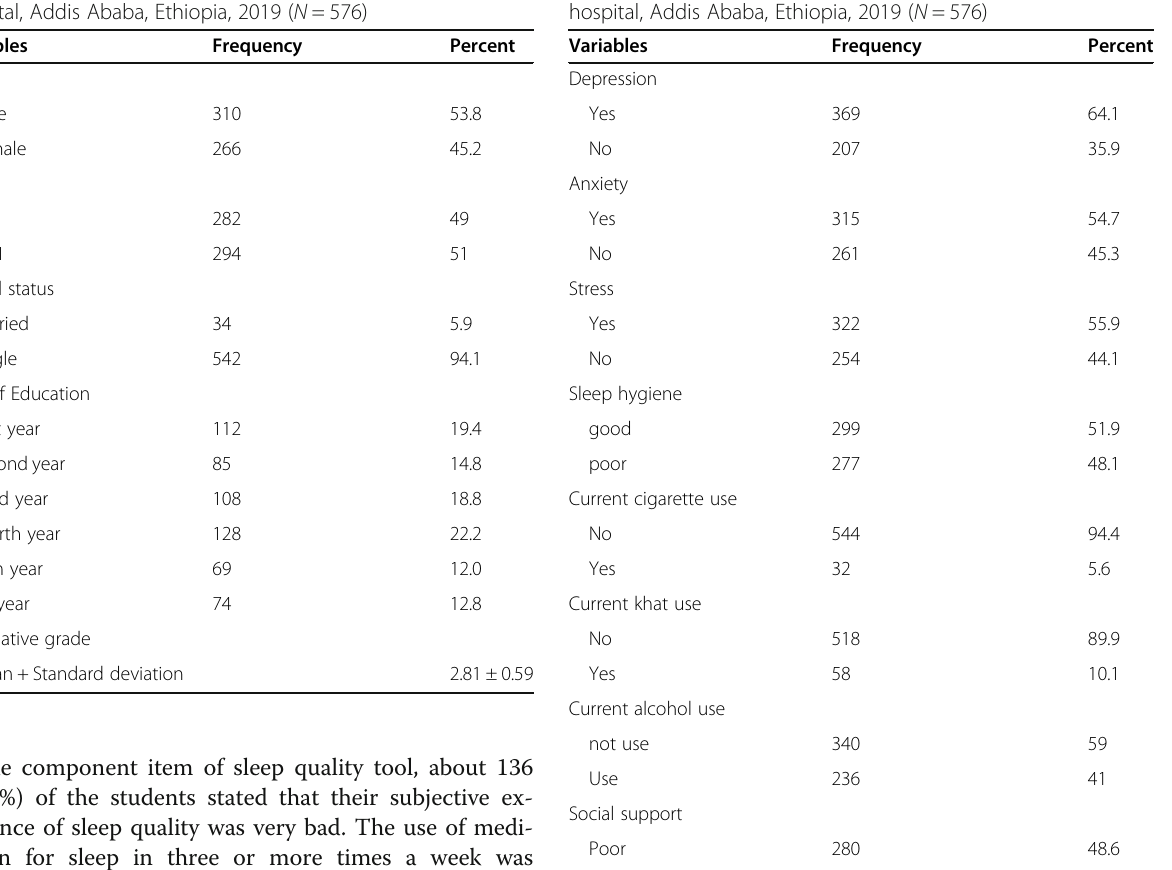
Table 2 Clinical, Substance and Social factors